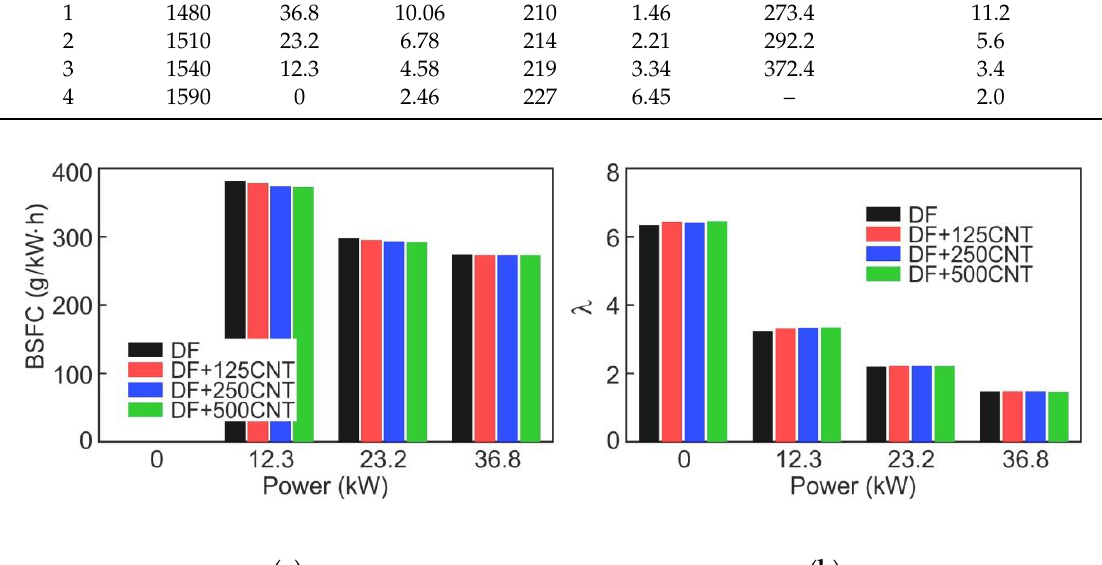
Figure 6. Change in BSFC ( a ) and air–fuel equivalence ratio λ ( b ) depending on the amount of CNT addition at different diesel engine loads.